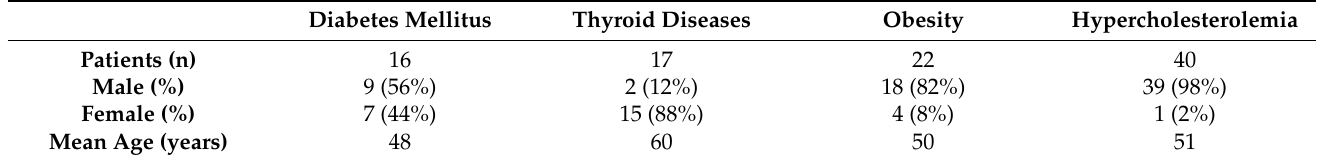
Table 3. Baseline characteristics of the dysmetabolic